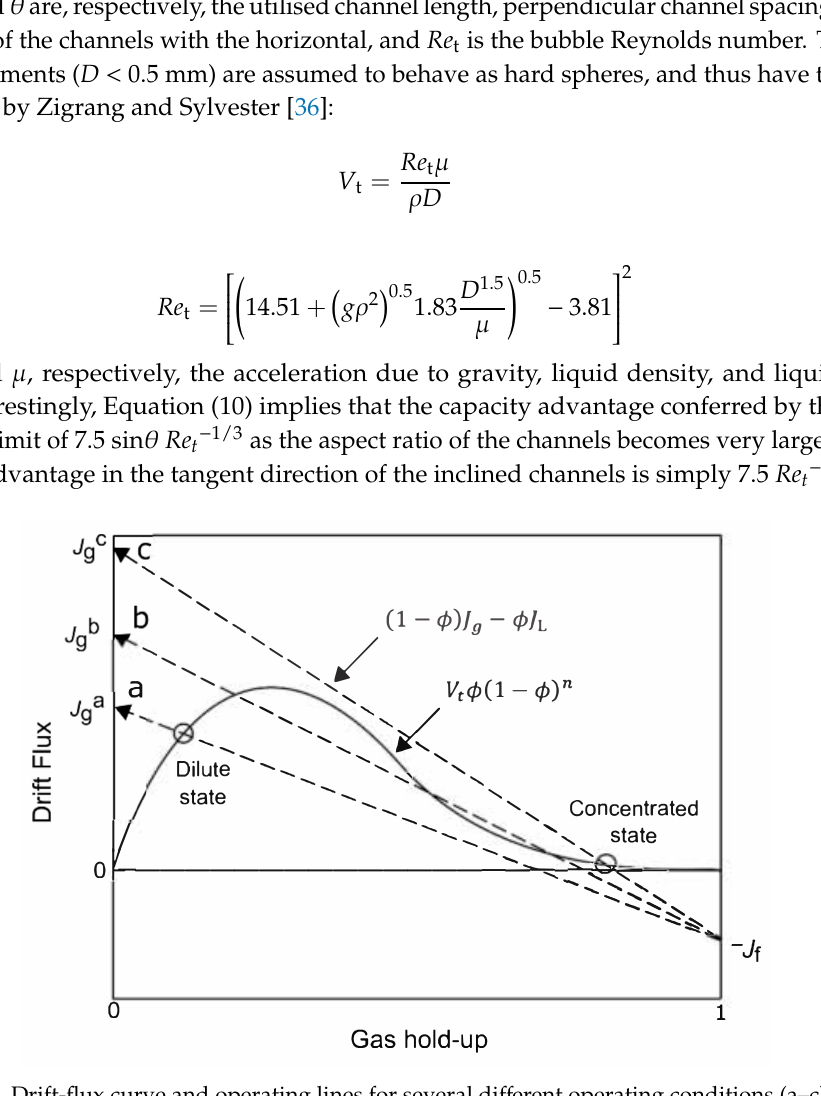
Figure 2. Drift-flux curve and operating lines for several di ff erent operating conditions (a–c)